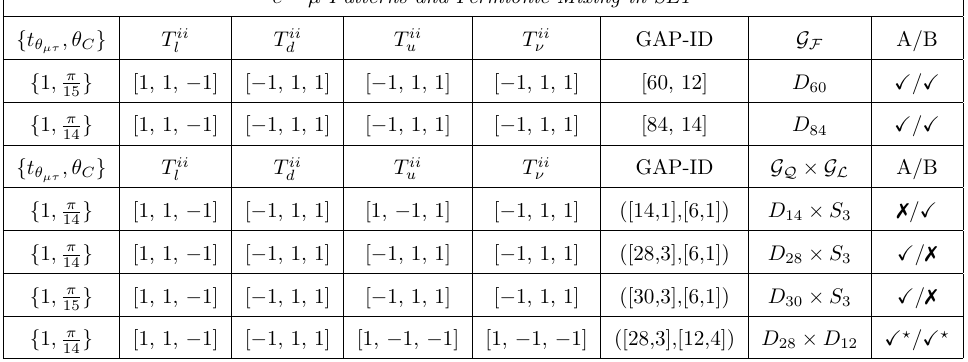
Table 4 . Flavour symmetries controlling (cid:21) [ e(cid:22)X ] , U C , and U (cid:22)(cid:28) in SE1. When a group is found for dl both Patterns A and B , the phase assignments given are for Pattern A . These results hold for all